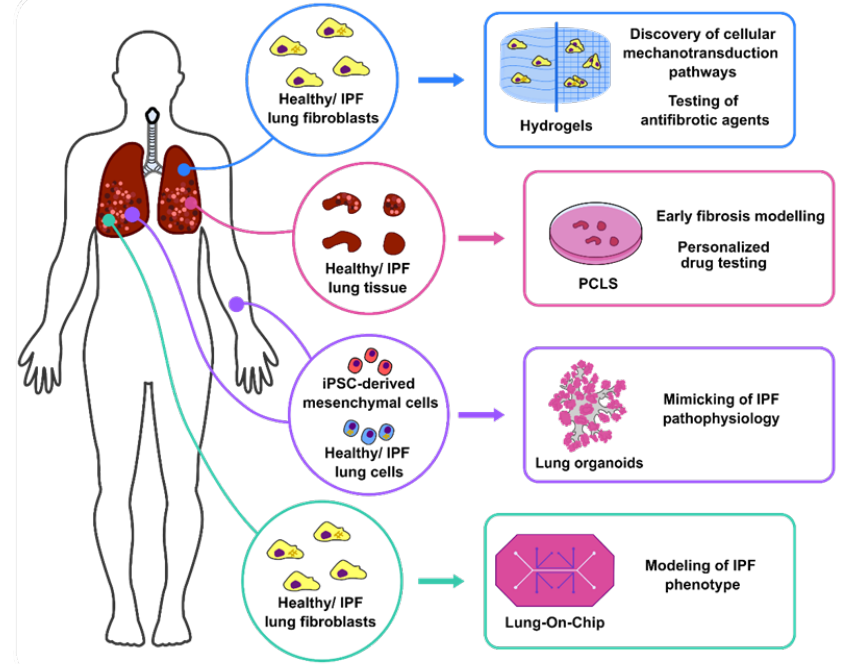
Figure 1. Current human 3D in vitro systems used in IPF research. Lung fibroblasts obtained from healthy donors and IPF patients can be cultured in hydrogels with different stiffness to study cellular mechanotransduction and drug testing. PCLS obtained from patients are being used for modelling early fibrosis and drug screening. In addition, lung organoids derived from lung epithelial stem cells and iPSCs-derived mesenchymal cells have been proven to model IPF pathophysiology, therefore, potentially aiding personalised medicine. Lastly, lung-on-chip devices recapitulate IPF phenotype by culture of fibroblasts isolated from donors and IPF lung tissues together with vascular and lung epithelial cells.